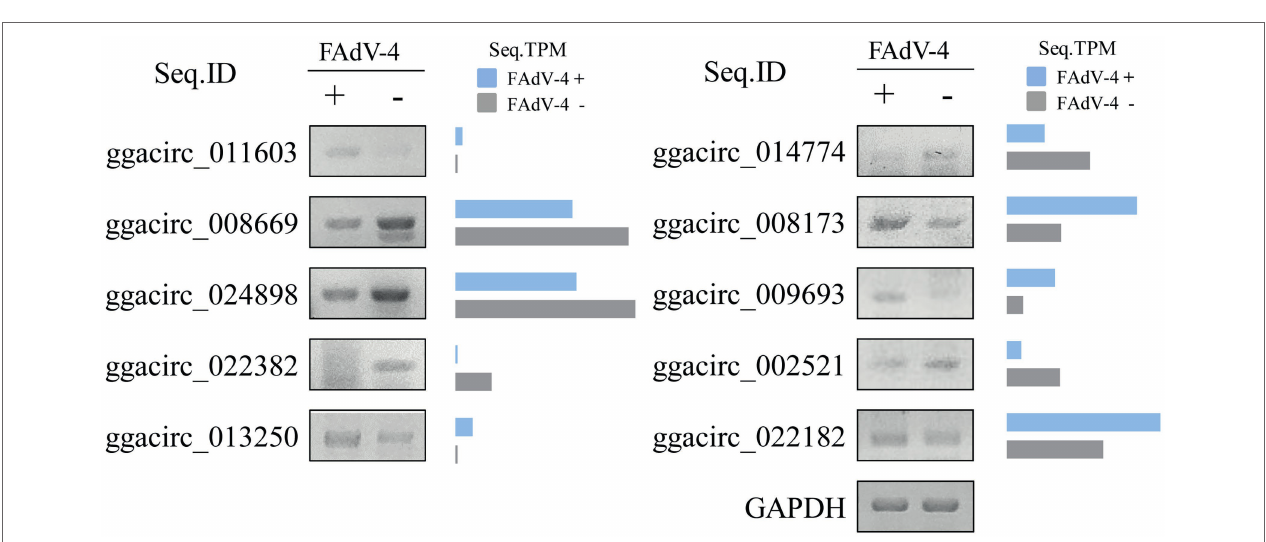
FIGURE 5 | Validation of ggacircRNAs. (A) ggacircRNA was detected by Semi-Quantitative RT-PCR using divergent primers. The right histogram represents the expression level of RNA-seq results. Ten ggacircRNAs (ggacirc_011603, ggacirc_008669, ggacirc_024898, ggacirc_022382, ggacirc_013250,